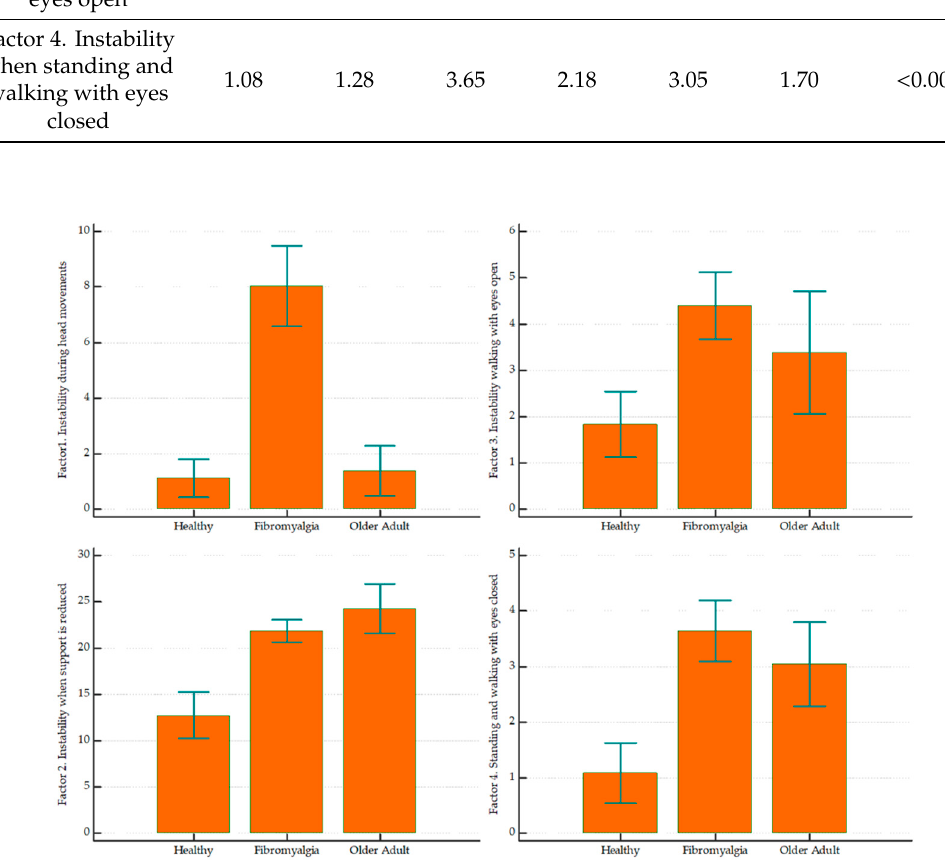
Figure 2. Mean differences between FMS patients, healthy individuals, and older adult subjects for each factor of the 20-item JAEN screening tool. Error bars indicate 95% confidence interval for the mean.